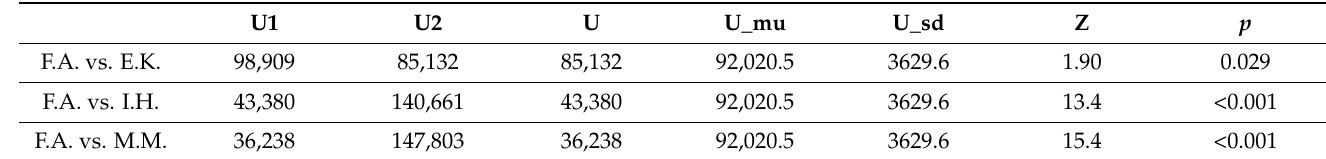
Table 2. Comparison between F.A. and the other observers (E.K., I.H., and M.M.) using Mann– Whitney U-test.